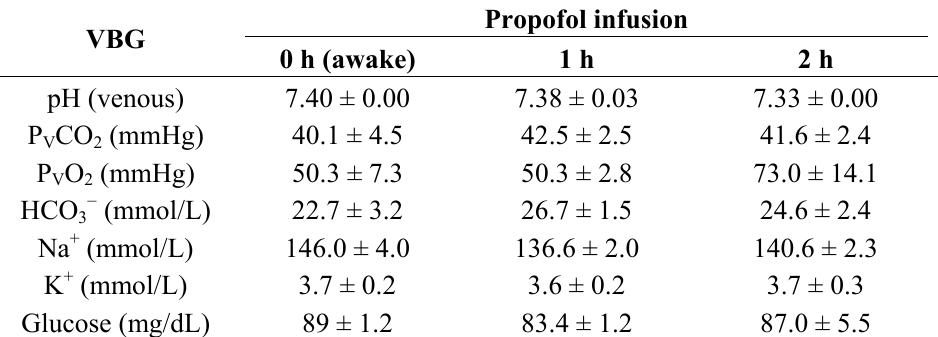
Table 1. Maternal venous blood gas and glucose levels during propofol